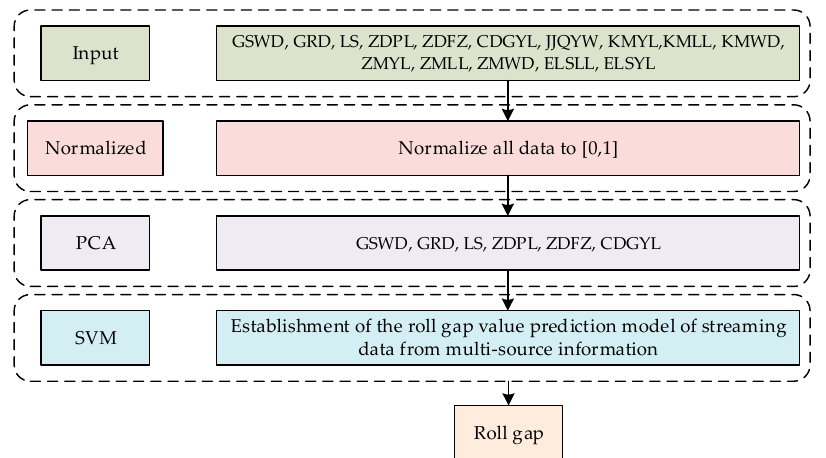
Figure 5. Common computational architecture of roll gap value prediction model.